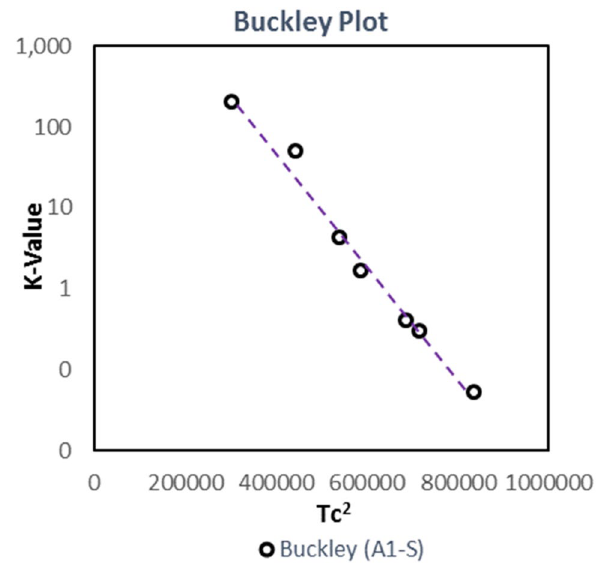
Fig. 17 Valid Hoffman plot—recombination test